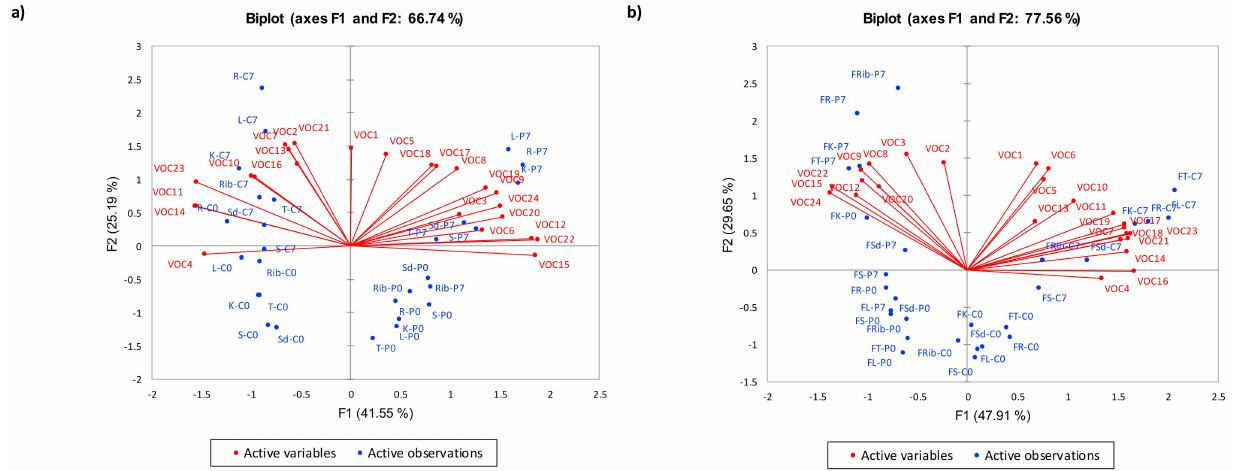
Figure 4. Principal Component Analysis Biplot of volatile profiles of PEF and non-PEF treated cooked chilled with 66.74% variance explained ( a ) and frozen-thawed with 77.56% variance explained ( b ) lamb meat of different cuts. Sd = Shoulder; Rib = Rib; L = Loin; K = Knuckle; R = Rump; S = Shank; T = Topside; C: control; P: PEF; 0 = 0 days storage; 7 = 7 days storage/post-processing storage. VOC codes for Figure 4a correspond to Supplementary Table S2 for chilled samples, and codes in Figure 4b correspond to Supplementary Table S3 for frozen